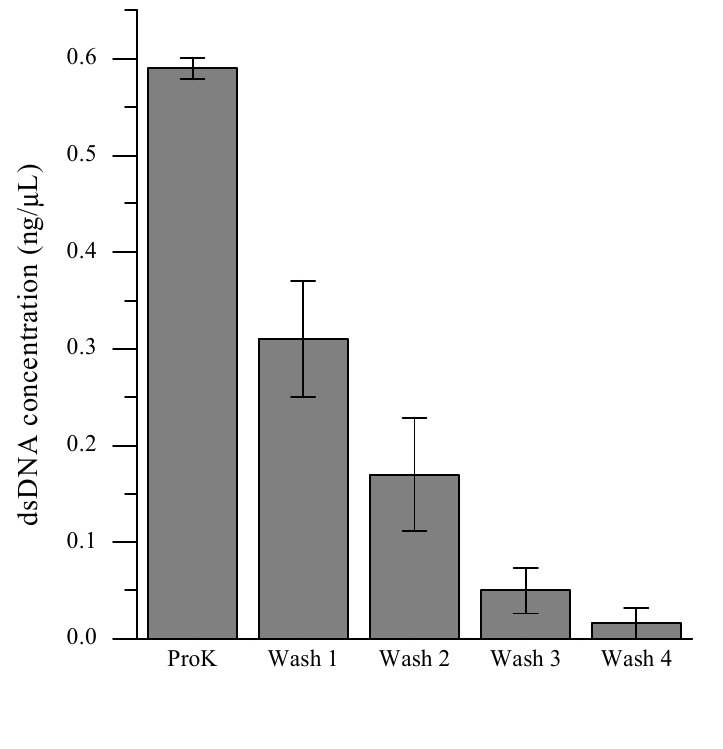
Figure 3. Removal of extracellular DNA via multiple washings of cell pellets before injecting into the microfluidic device. dsDNA concentration of the supernatant solutions were determined via PicoGreen fluorescence assay. ProK refers to proteinase